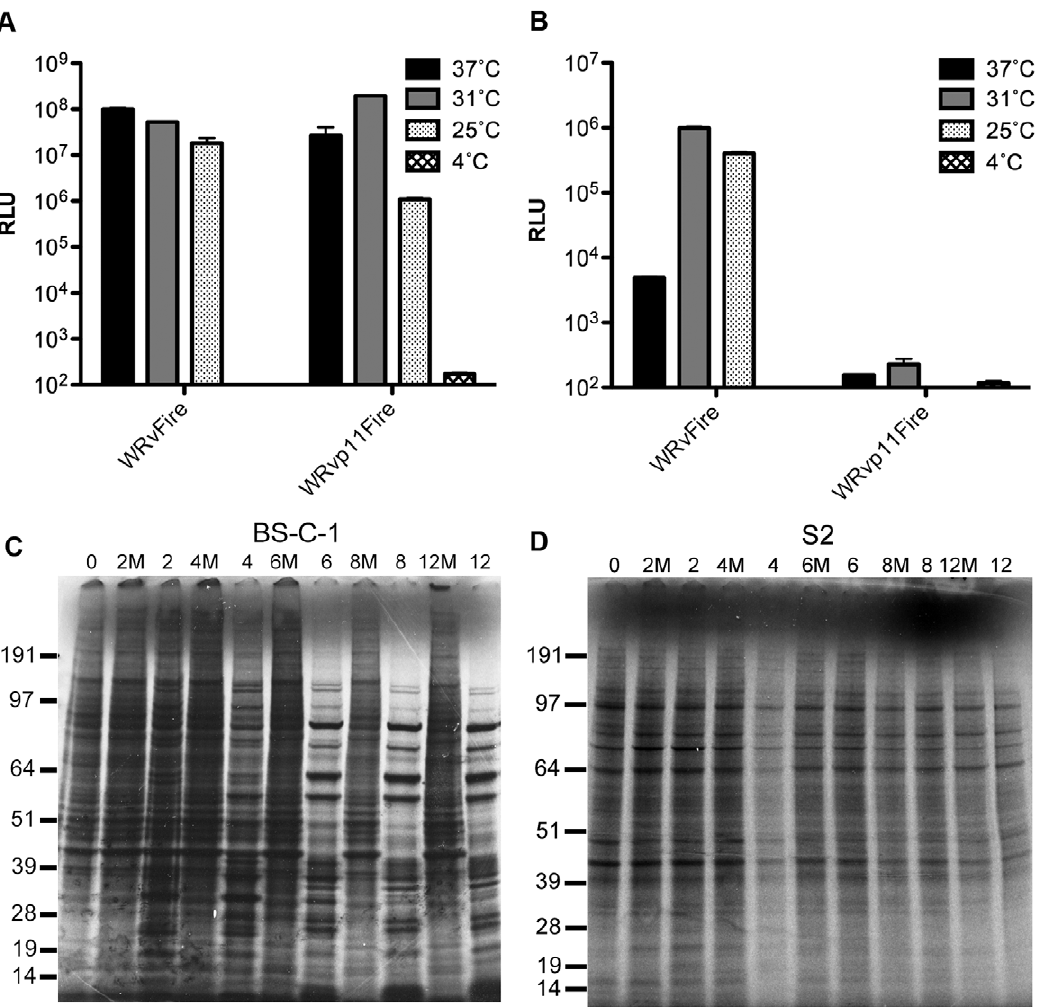
Figure 8. Late gene expression. BS-C-1 ( A ) and S2 ( B ) cells were infected at an MOI of 1 PFU per cell with a recombinant VACV with Luc regulated under the VACV early/late synthetic promoter (WRvFire) or the p11 late promoter (WRvp11Fire) at indicated temperatures. Luc activity was measured at 16 h after infection. Standard error bars were plotted in both panels but are too close to discern in some places. BS-C-1 ( C ) and S2 ( D ) cells were infected with VACV at an MOI of 20 PFU per cell and pulse-labeled with 35 S-labeled amino acids for 30 min intervals at the times indicated and analyzed by sodium dodecyl sulfate-polyacrylamide gel electrophoresis and autoradiography. The masses of marker proteins in kDA are indicated on the left. M denotes mock-infected cells.